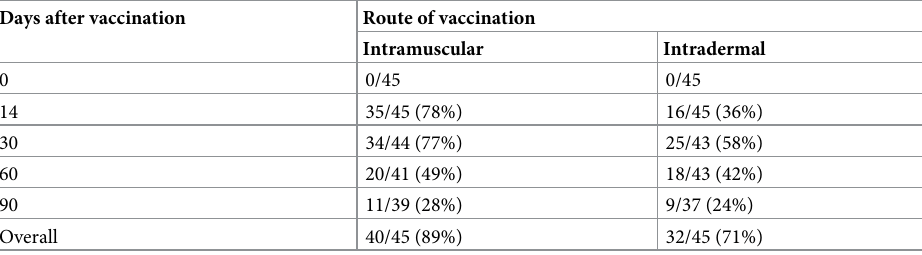
Table 4. Proportion of cattle with VNA titre � 0.5 IU/mL at 0,14,30,60 and 90 days.